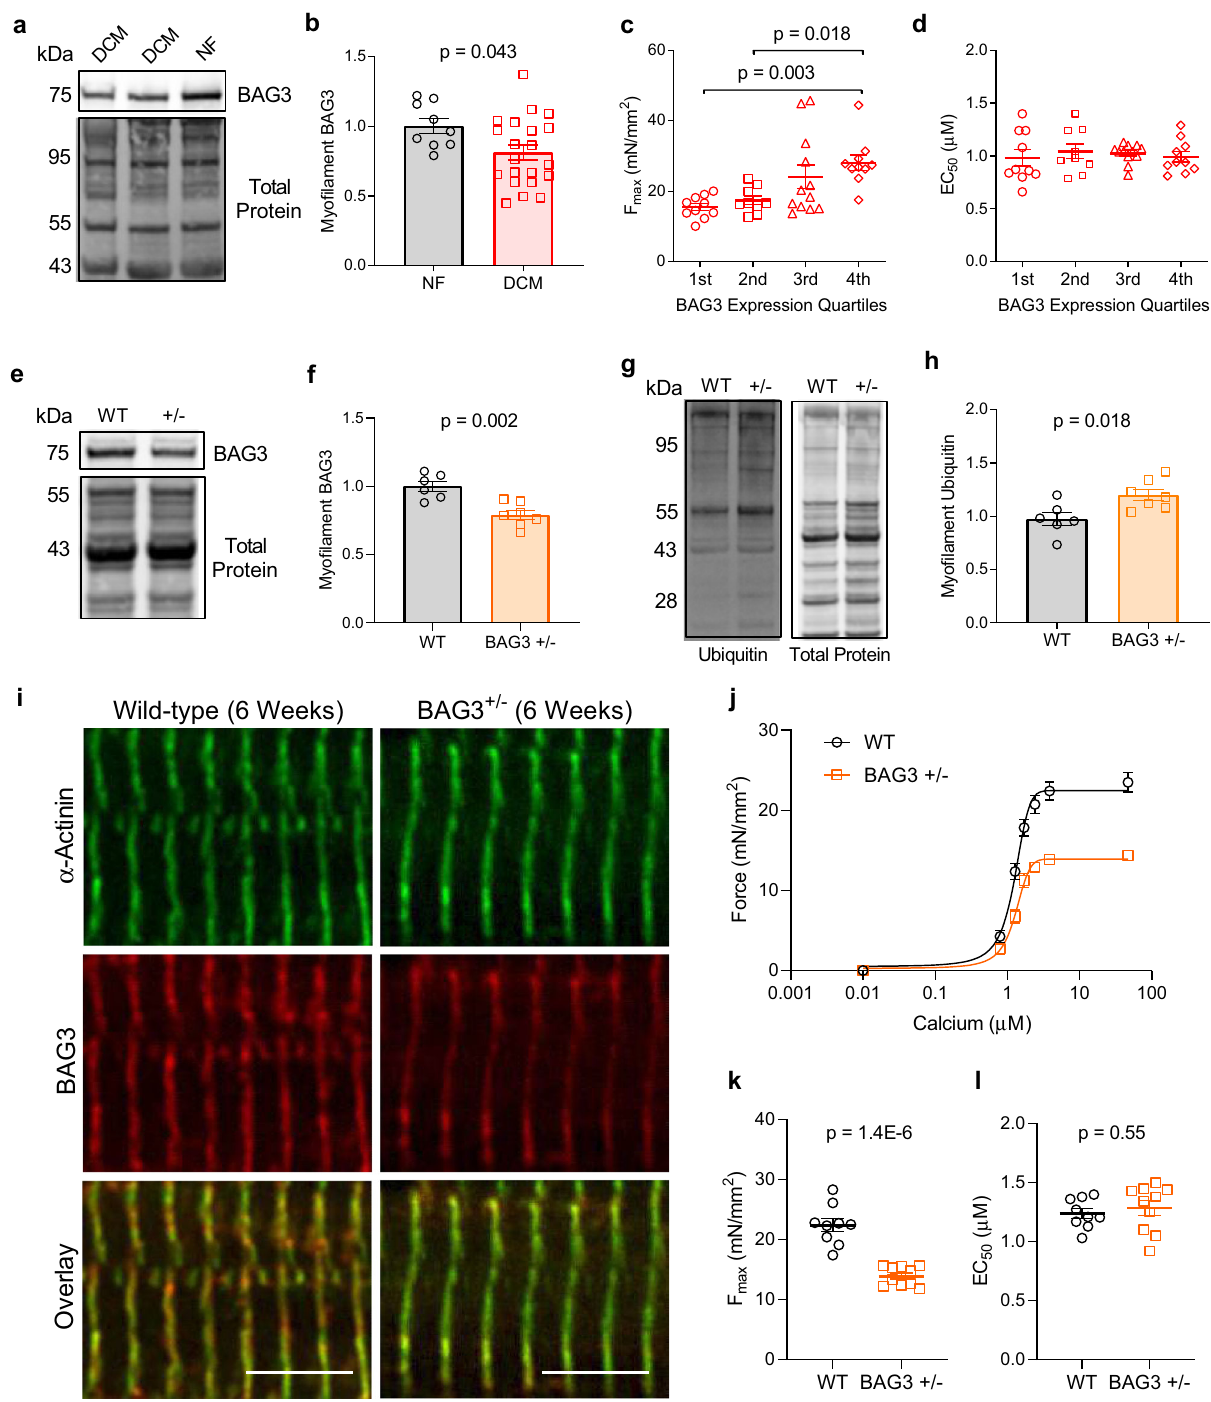
Fig. 2 Sarcomeric BAG3 expression decreases in DCM and is associated with reduced myo fi lament F max . a Western blot for myo fi lament BAG3 in NF and DCM humans; image is representative of 9 NF samples and 21 DCM samples. b Myo fi lament BAG3 signal normalized to total protein; n = 9 NF, 21 DCM; two-tailed t -test. c, d DCM myocyte F max ( c ) and EC 50 ( d ) grouped by quartile of BAG3 expression; 1st = lowest BAG3 expressors; n = 12 DCM samples, 3 – 4 myocytes/sample for functional assessment; one-way ANOVA, Tukey post-hoc. e Western blot for myo fi lament BAG3 in WT and BAG3 + / − mice; image is representative of six WT and seven BAG3 + / − samples. f BAG3 signal normalized to total protein; n = 6 WT, 7 BAG3 + / − ; two-tailed t -test. g Western blot for myo fi lament ubiquitin in WT and BAG3 + / − mice; image is representative of six WT and seven BAG3 + / − samples. h Ubiquitin signal normalized to total protein; n = 6 WT, 7 BAG3 + / − ; two-tailed t -test. i Immuno fl uorescence image of WT and BAG3 + / − cardiomyocytes immunostained for α -actinin and BAG3; ×63 magni fi cation, scale bars = 5 µ m; image is representative of the 5/group acquired. j Skinned myocyte force-calcium relationship from WT and BAG3 + / − cardiomyocytes; n = 9 WT from 3 mice, 10 BAG3 + / − from 3 mice. k, l Summary data for myocyte F max ( k ) and EC 50 ( l ) corresponding to the force-calcium curves in j ; two-tailed t -test. All data are presented as mean ±